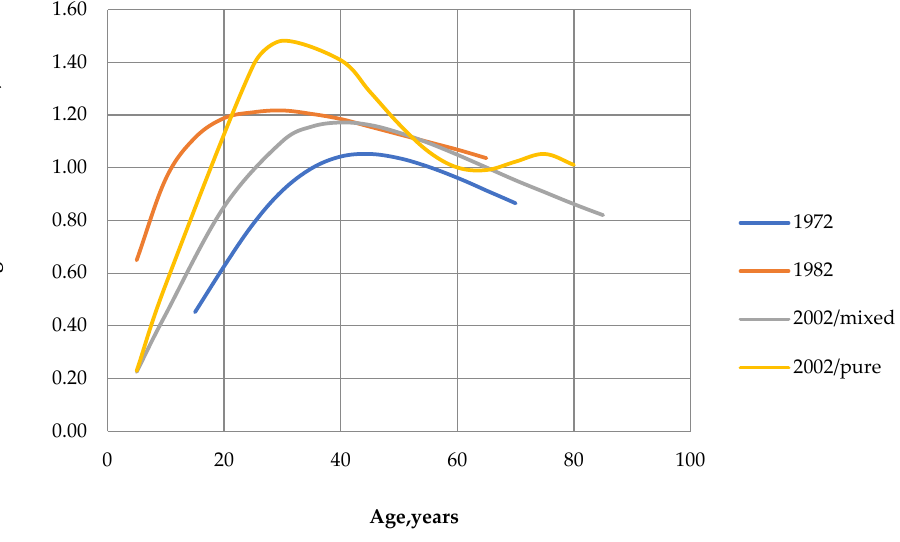
Figure 5. Trendlines indicating changes in the average annual carbon increment with age and inventory periods.